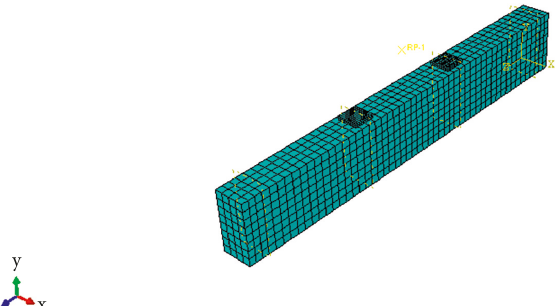
Figure 5: FEM model of concrete